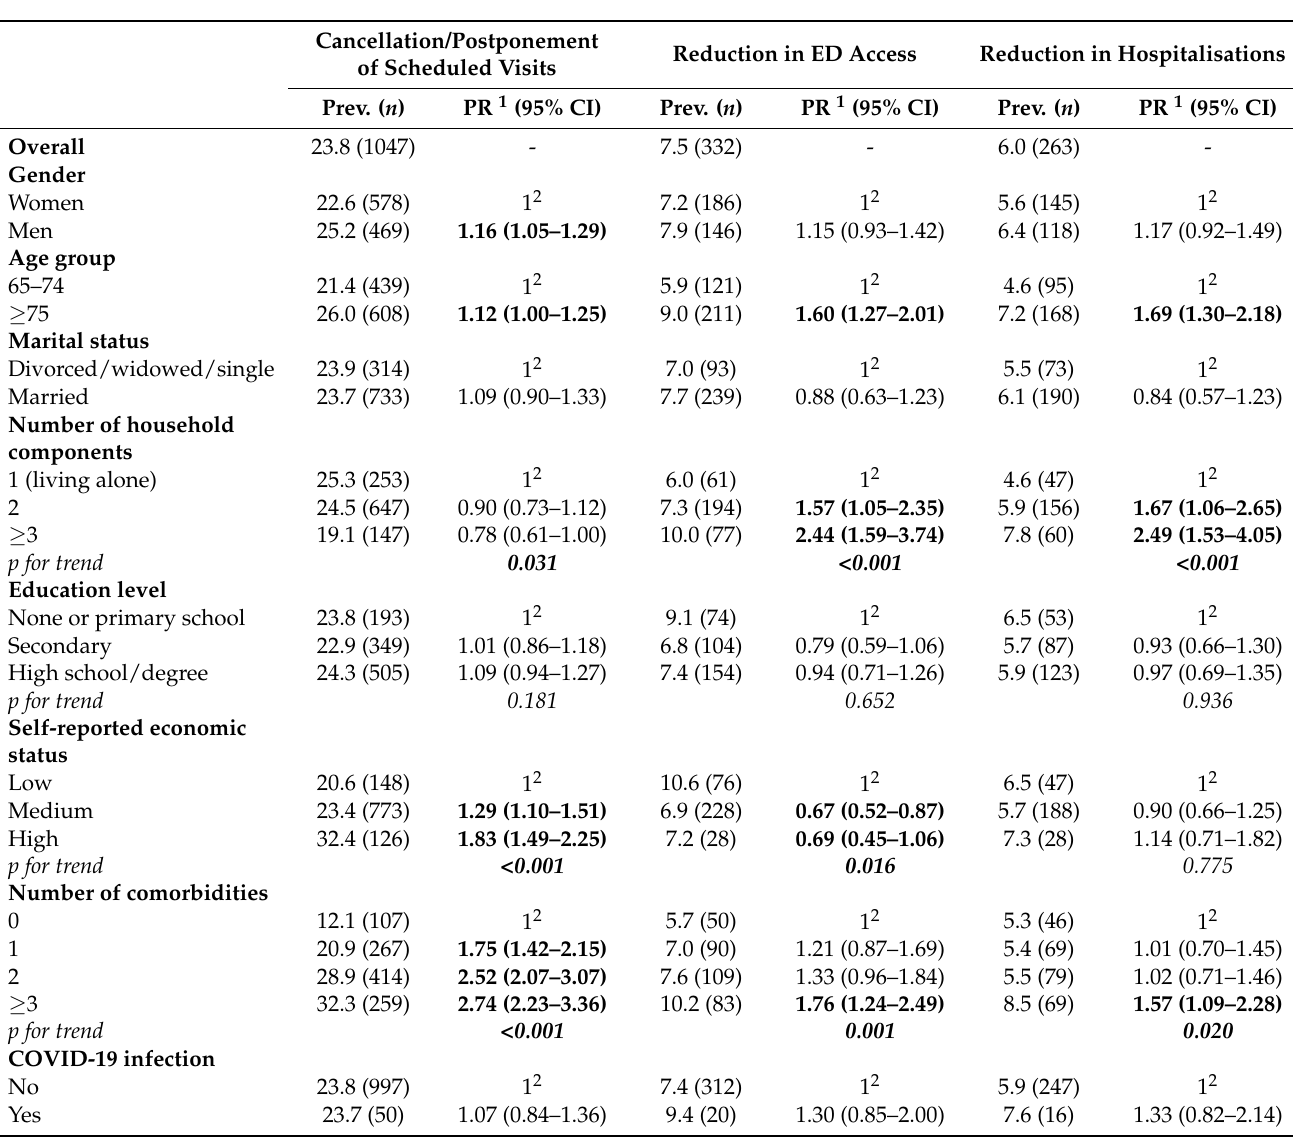
Table 3. Weighted prevalence (Prev.) and unweighted number ( n ) of the change in three selected healthcare service demands according to selected determinants, adjusted prevalence ratios (PR) and corresponding 95% confidence intervals